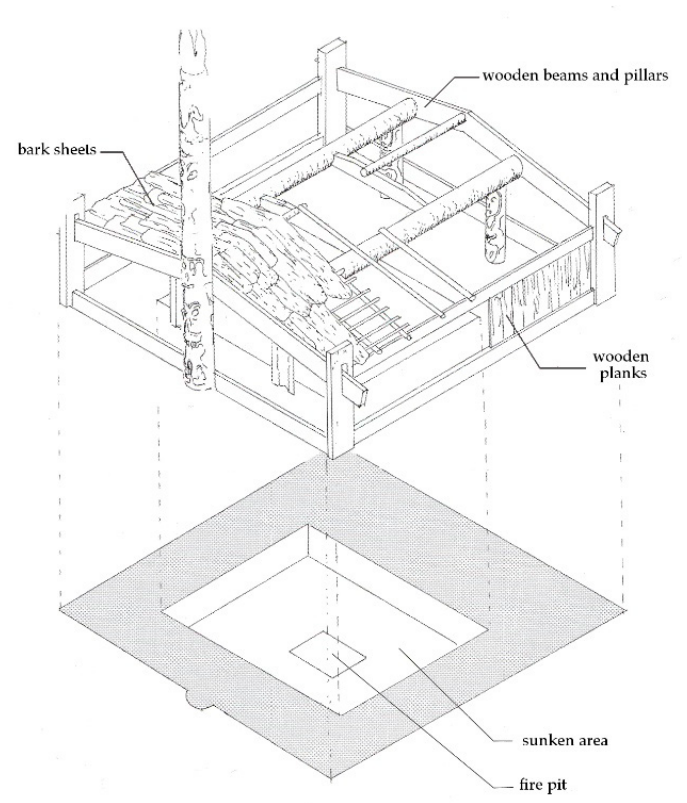
Figure 3. Exploded axonometric of a Haida dwelling construction system based on [9] (p. 171).